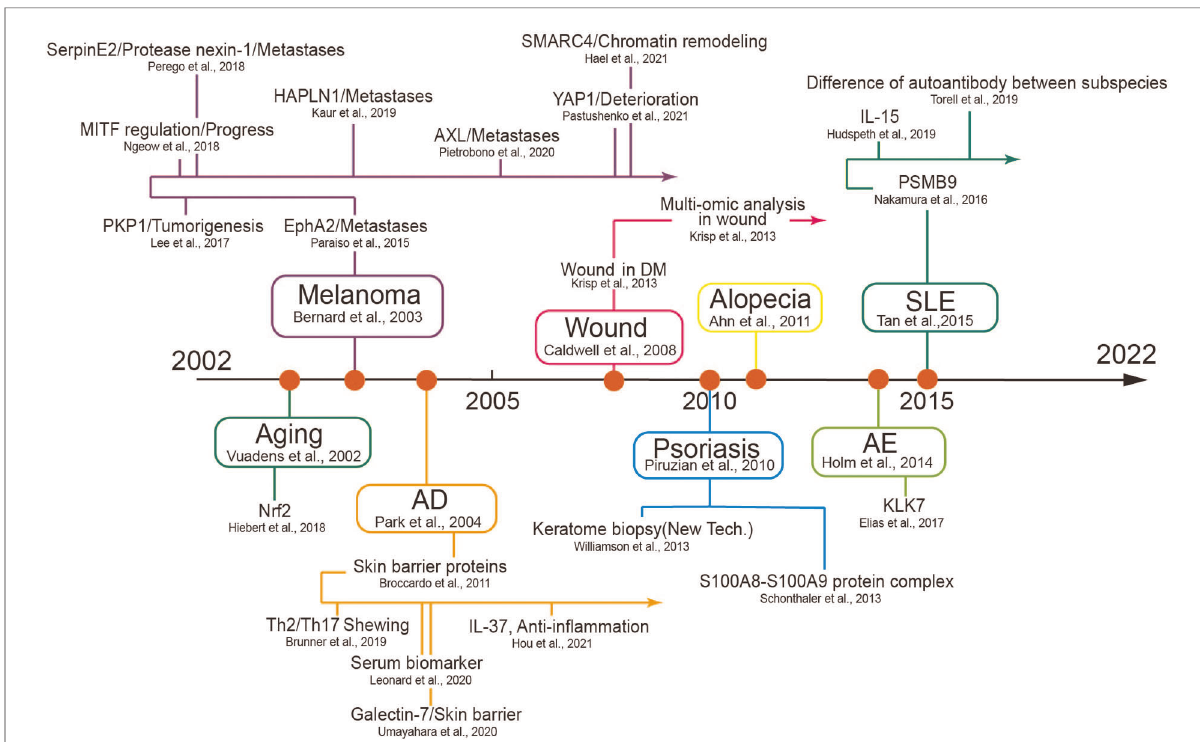
FIGURE 5 The timeline of some key discoveries in the fi eld of the skin disease using proteomics. The fi rst records of proteomics used in several diseases and their subsequent development are listed here. We selected primary skin diseases that began in different periods to list and used high-impact factor articles as developing nodes to display in the follow-up development process AD, atopic dermatitis; SLE, systemic lupus erythematosus; AE, atopic eczema; PKP1, plakophilin-1; HAPLN1, hyaluronan and proteoglycan link protein 1; AXL, AXL receptor tyrosine kinase; YAP1, yes-associated protein 1; MITF, microphthalmia-associated transcription factor: DM, diabetes mellitus; KLK7,